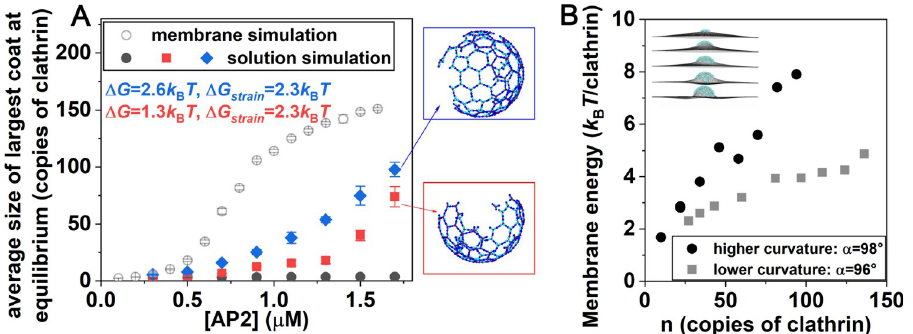
Fig 6. Curved-cage assembly in solution requires added stabilization, which is comparable to membrane bending energies. (A) Clathrin cages with adaptors present do not form in solution (black dots), using the same model as on the membrane (open circles), despite the same concentration of clathrin. With added stabilization for all clathrin- clathrin bonds ( Δ G ) and reduced strain ( Δ G strain ), solutions cages start to form (red and blue), although growth is less cooperative without dimensional reduction following membrane localization. (B) Membrane bending energy per clathrin trimer as the sizes n of curved lattices are increased. More highly curved cages ( α = 98 o ) cost more energy per trimer to bend the membrane. The membrane energy is proportional to the bending modulus κ , where we use κ = 20 k B T consistent with measurements on the plasma membrane